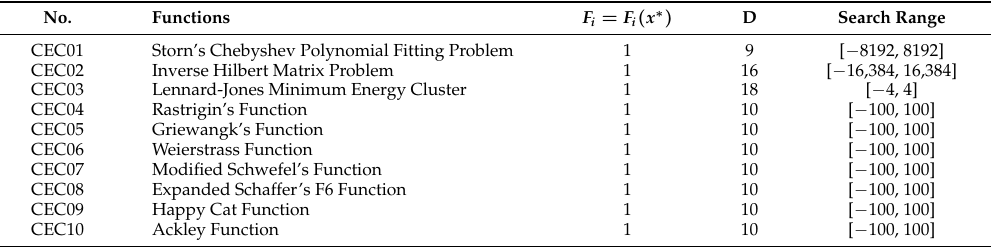
Table 1. CEC 2019 benchmark characteristics.